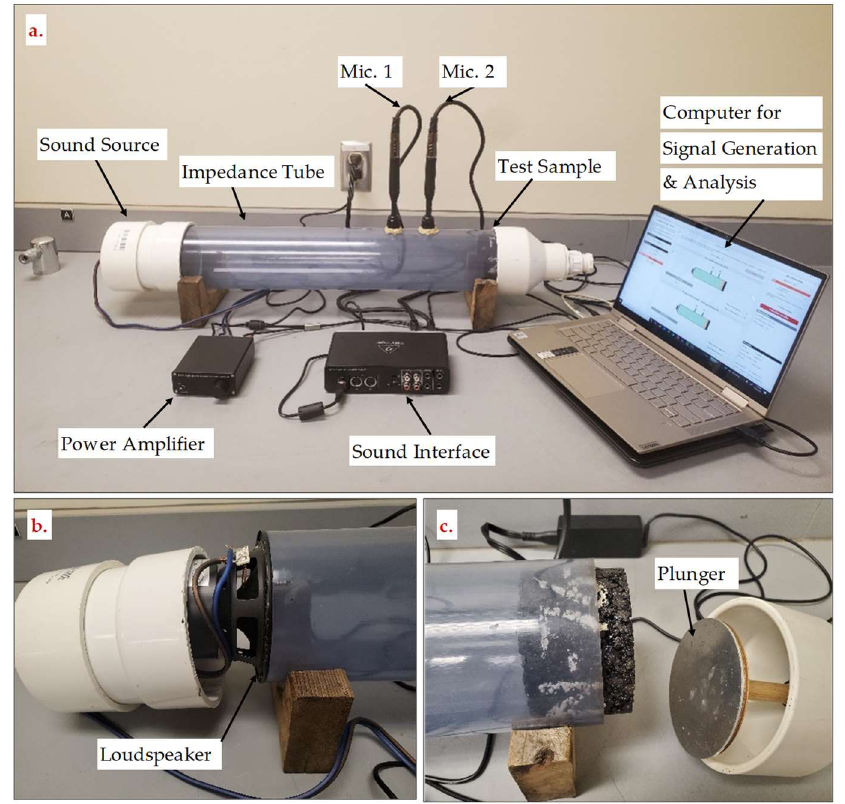
Figure 4. ( a ) Impedance tube used for the sound absorption testing; ( b ) loudspeaker end; ( c ) test sample and hard-backing end.